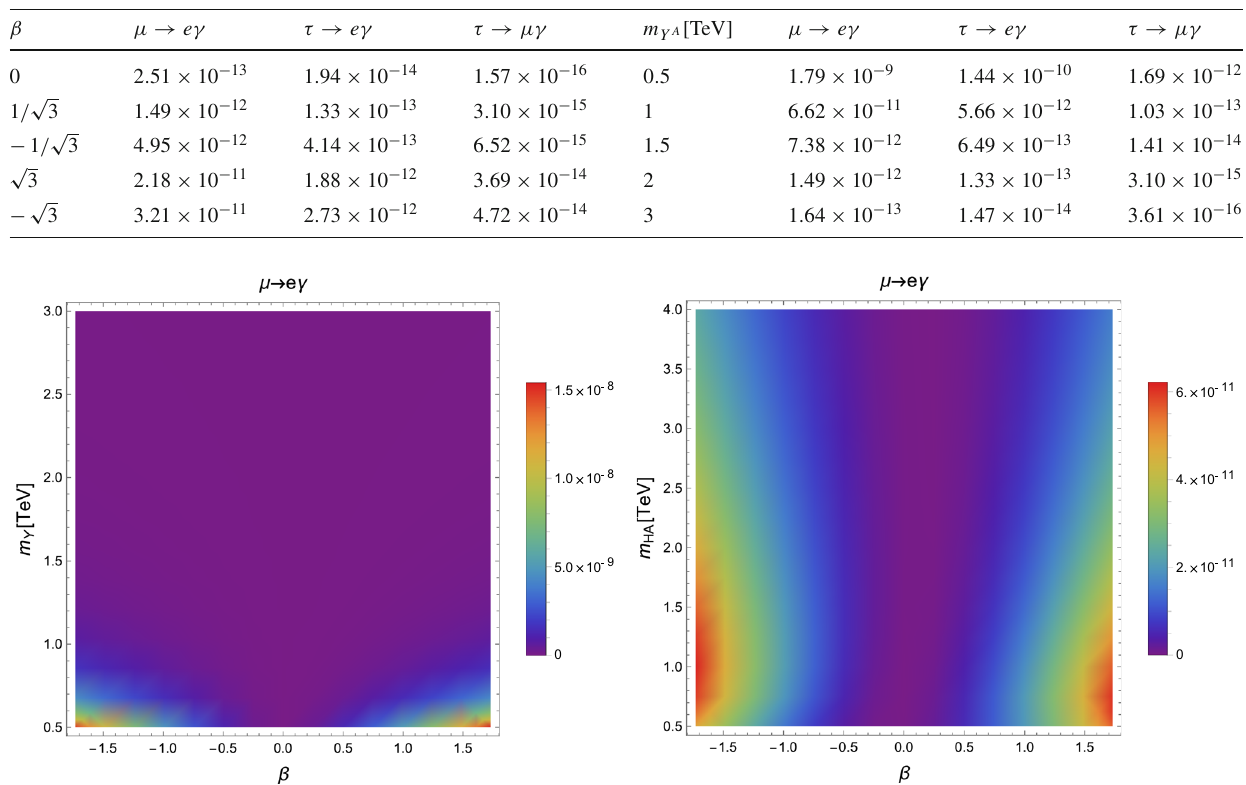
Table 4 Branching fractions of l 1 → l 2 γ at various values of β , m Y A . Other parameters are fixed as given in the text